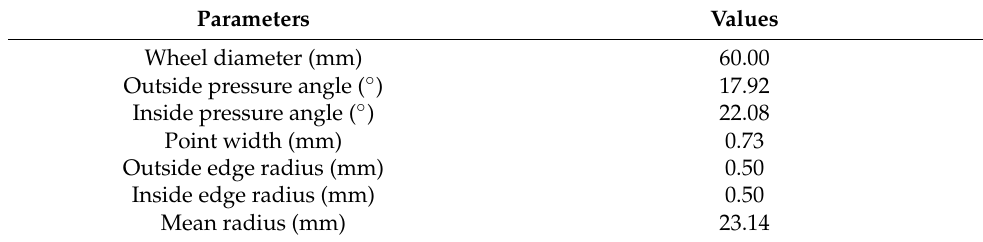
Figure 2. RUAG kinematic models: ( a ) grinding wheel model, ( b ) abrasive grain’s trajectory, ( c ) abrasive grain model, and ( d ) micro-pit model. Table 1. Grinding wheel’s dimensions.